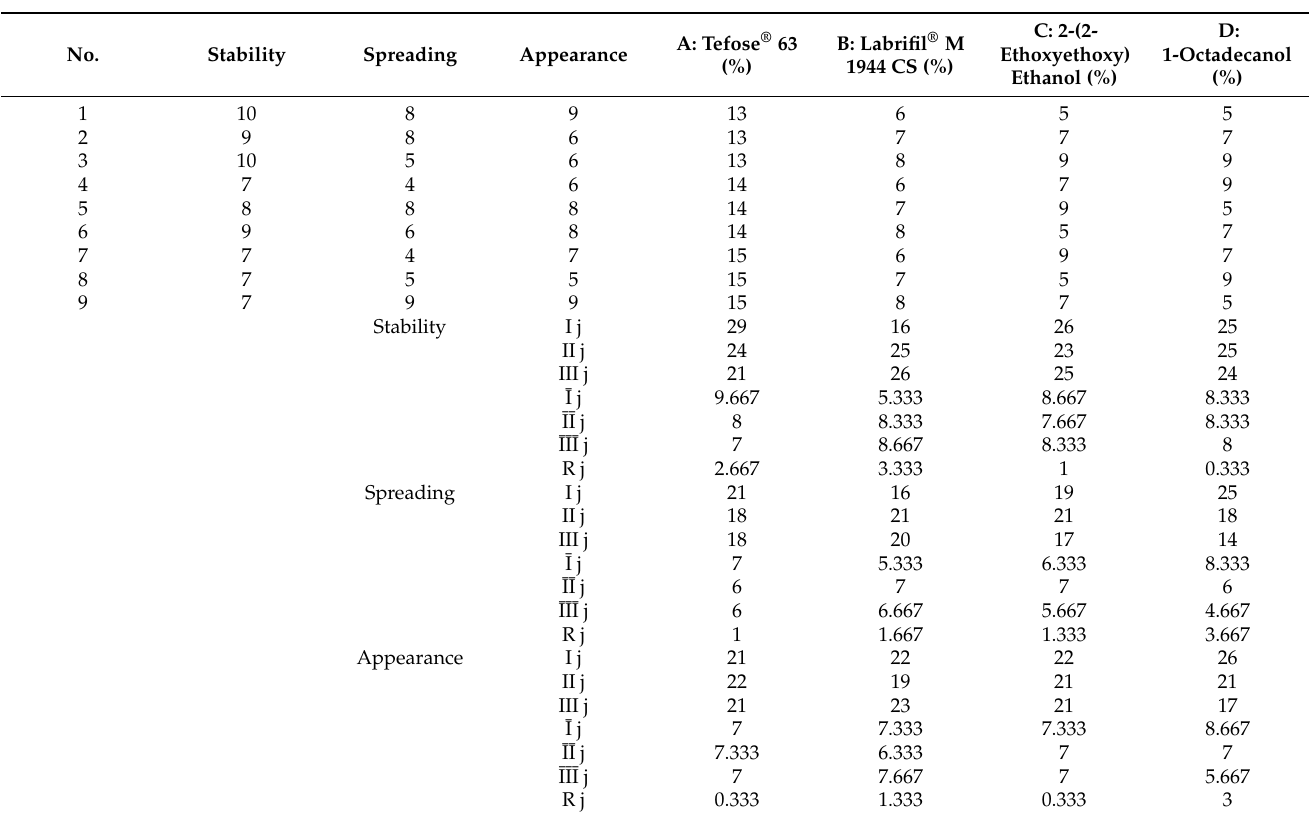
Table 3. Orthogonal analysis.